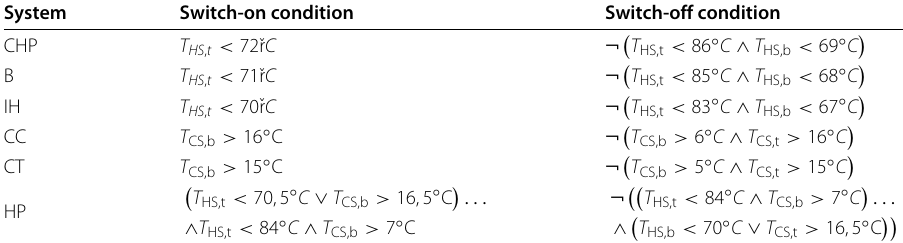
Table 1 Hysteresis parameters for conventional operation strategy (Panten